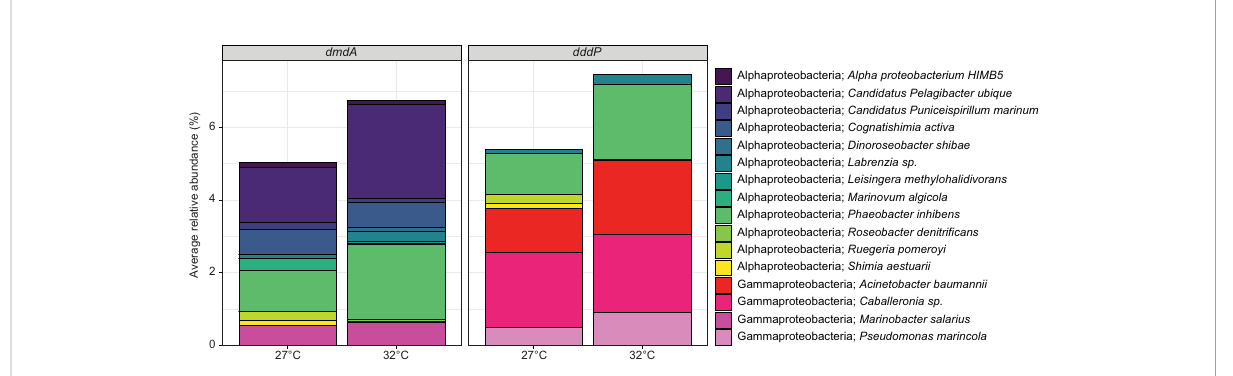
FIGURE 4 Average relative abundance (%) of ASVs that were taxonomically assigned to bacteria (>95% similarity) harbouring the DMSP-degrading genes dmdA and/or dddP for mucus samples at timepoint T3, for the control (27°C) and temperature (32°C) treatments. Data were rare fi ed to the smallest sample size depth of